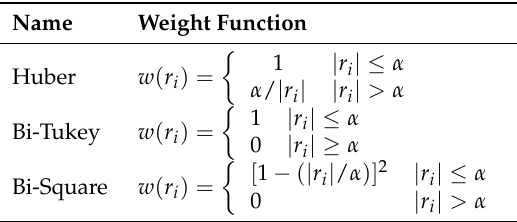
Table 1. Weighting functions